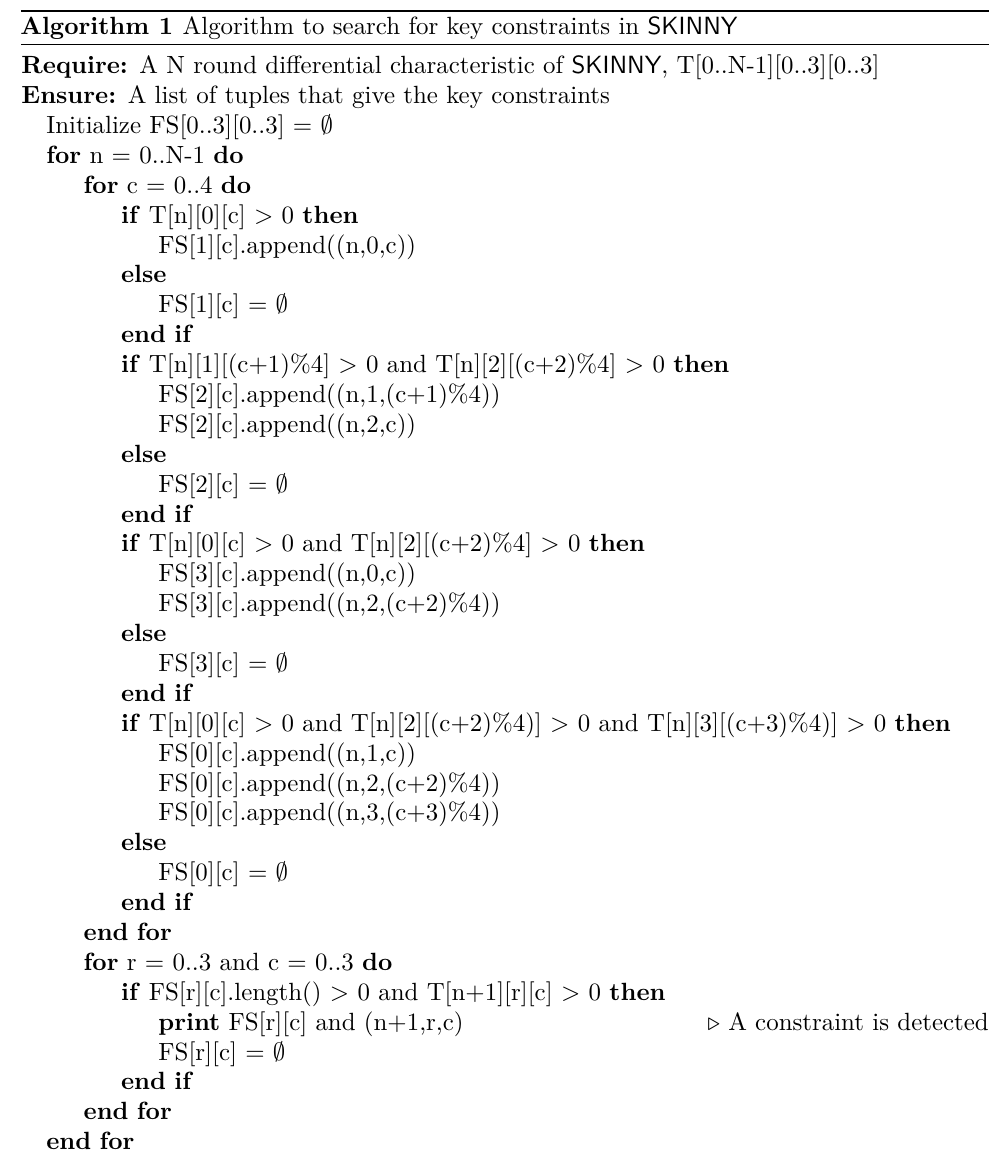
Algorithm 1 Algorithm to search for key constraints in